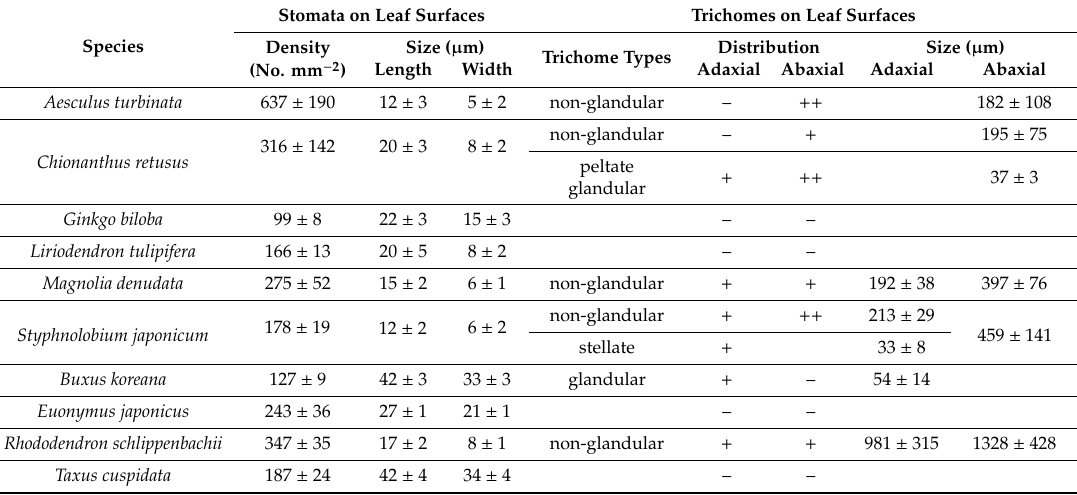
Table 3. Specific leaf micro-morphological characteristics (stomata and trichomes) on adaxial and abaxial leaf surfaces of ten species.